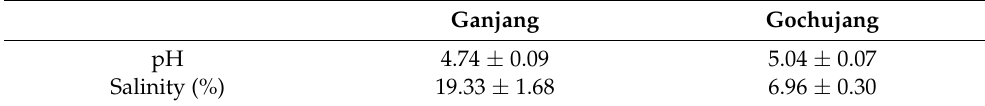
Table 1. The pH and salinity of commercially-available Ganjang and